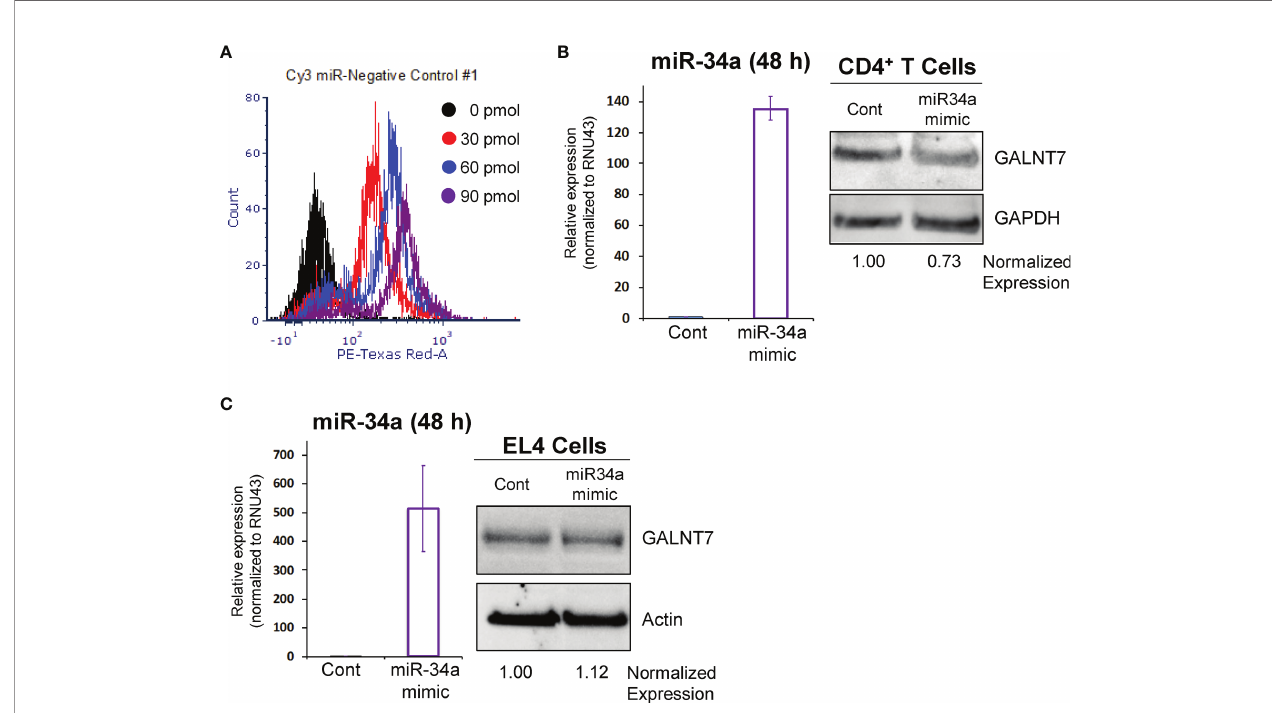
FIGURE 3 | miR-34a regulates GALNT7 expression in primary T Cells. (A) Optimization of miR-34a used in nucleofection. miR-34a was overexpressed in mouse CD4 + T cells (B) or EL4 cells (C) . miR-34a mRNA levels were assessed using qPCR. GALNT7 levels were measured using western blotting. Data from representative experiments are